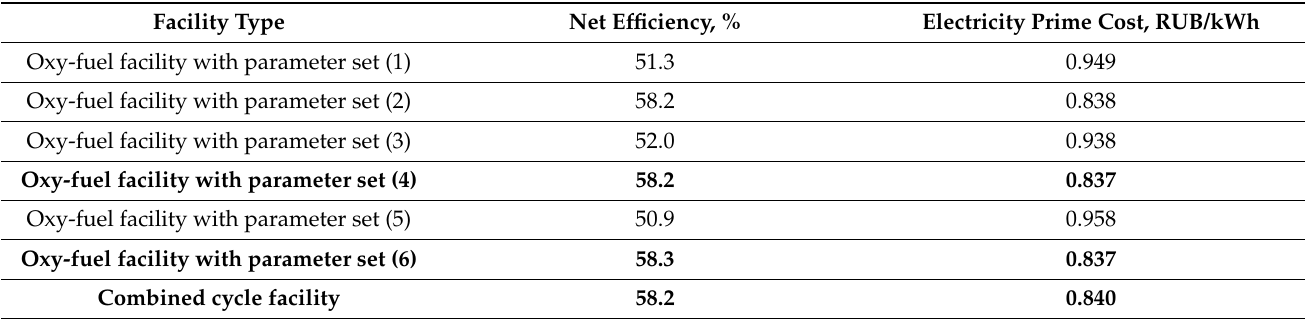
Table 7. Prime cost of electricity production with best parameters in oxy-fuel facilities and combined cycle ones.